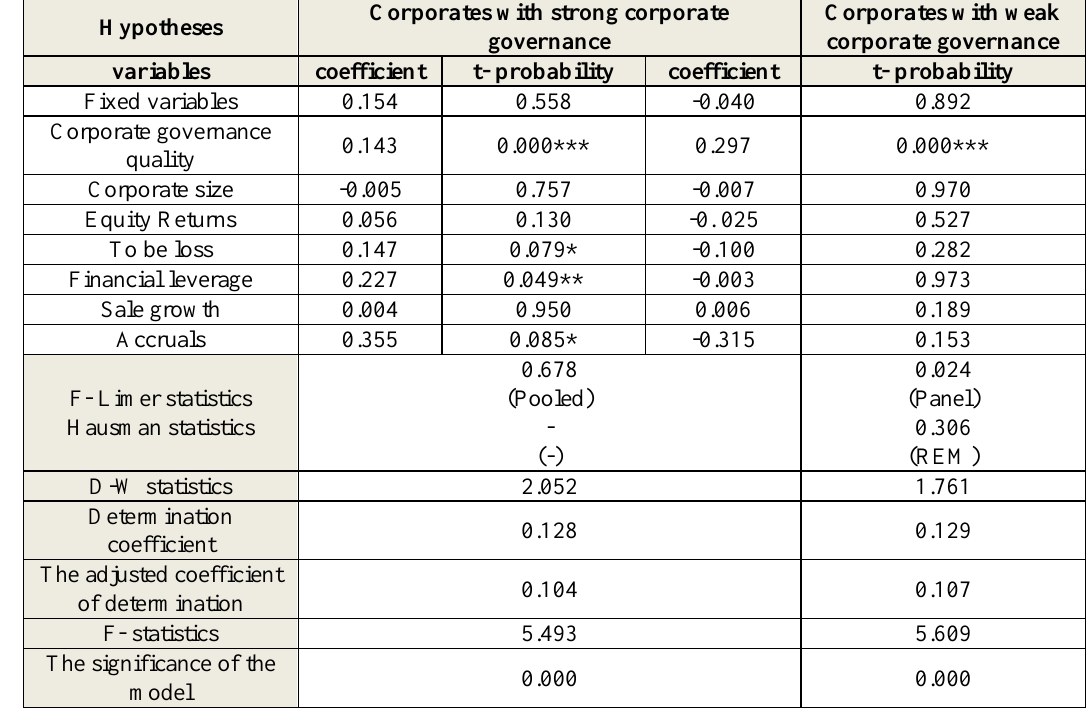
Table 6: Test results of the third